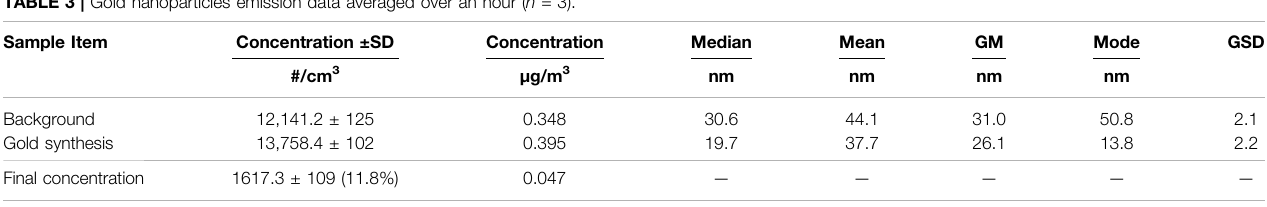
TABLE 3 | Gold nanoparticles emission data averaged over an hour ( n = 3).